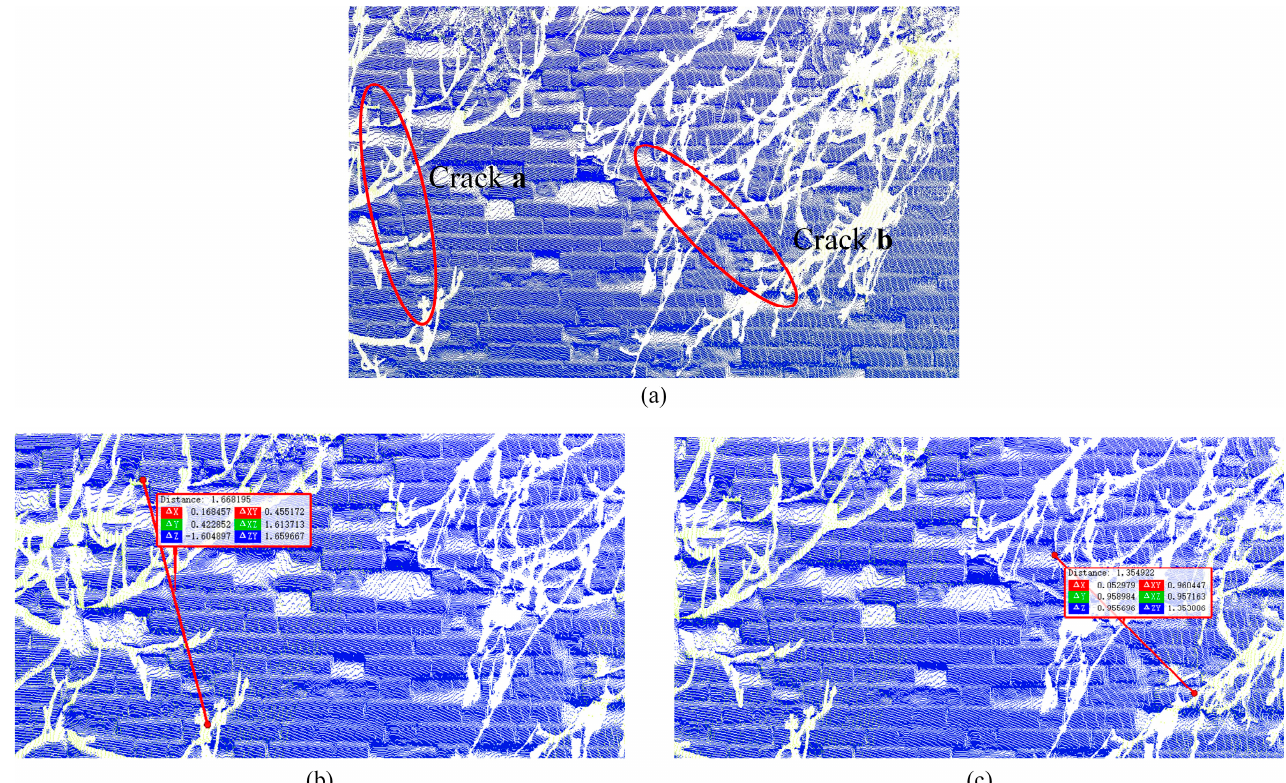
Figure 30. Crack measurement results. ( a ) Location diagram of two cracks. ( b ) Length measurement result of crack a. ( c ) Length measurement result of crack b.